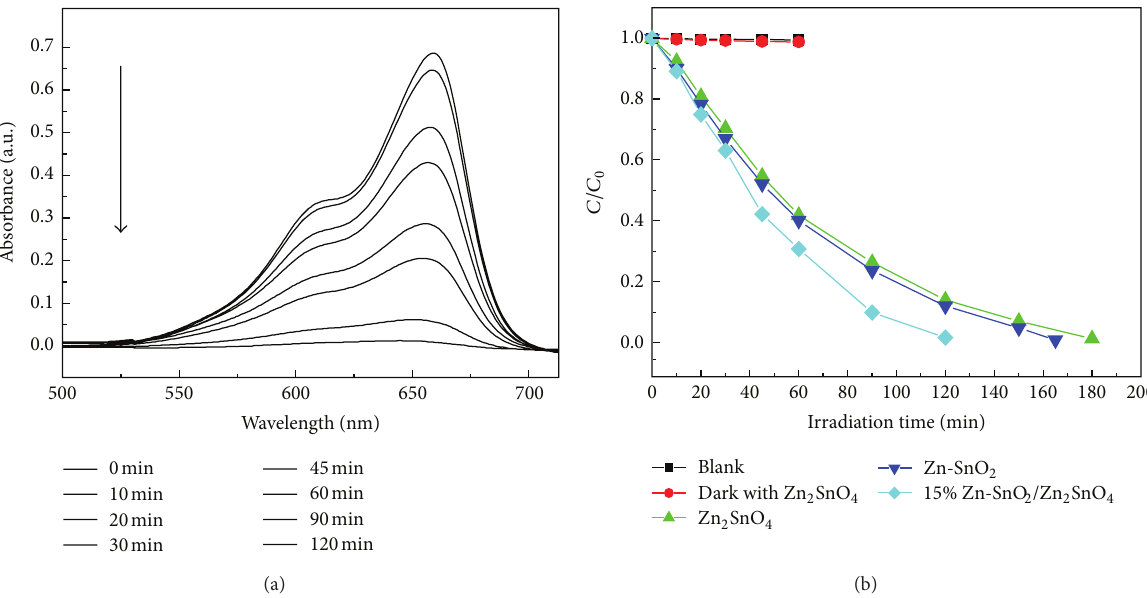
Figure 6: (a) The variations of adsorption spectra of aqueous MB in the presence of Zn-doped SnO 2 /Zn 2 SnO 4 nanocomposites at different periods of time under ultraviolet irradiation; (b) the comparisons of photocatalytic degradation activity of different photocatalysts, including pure Zn 2 SnO 4 , pure Zn-doped SnO 2 , and 15% Zn-doped SnO 2 /Zn 2 SnO 4 nanocomposites.